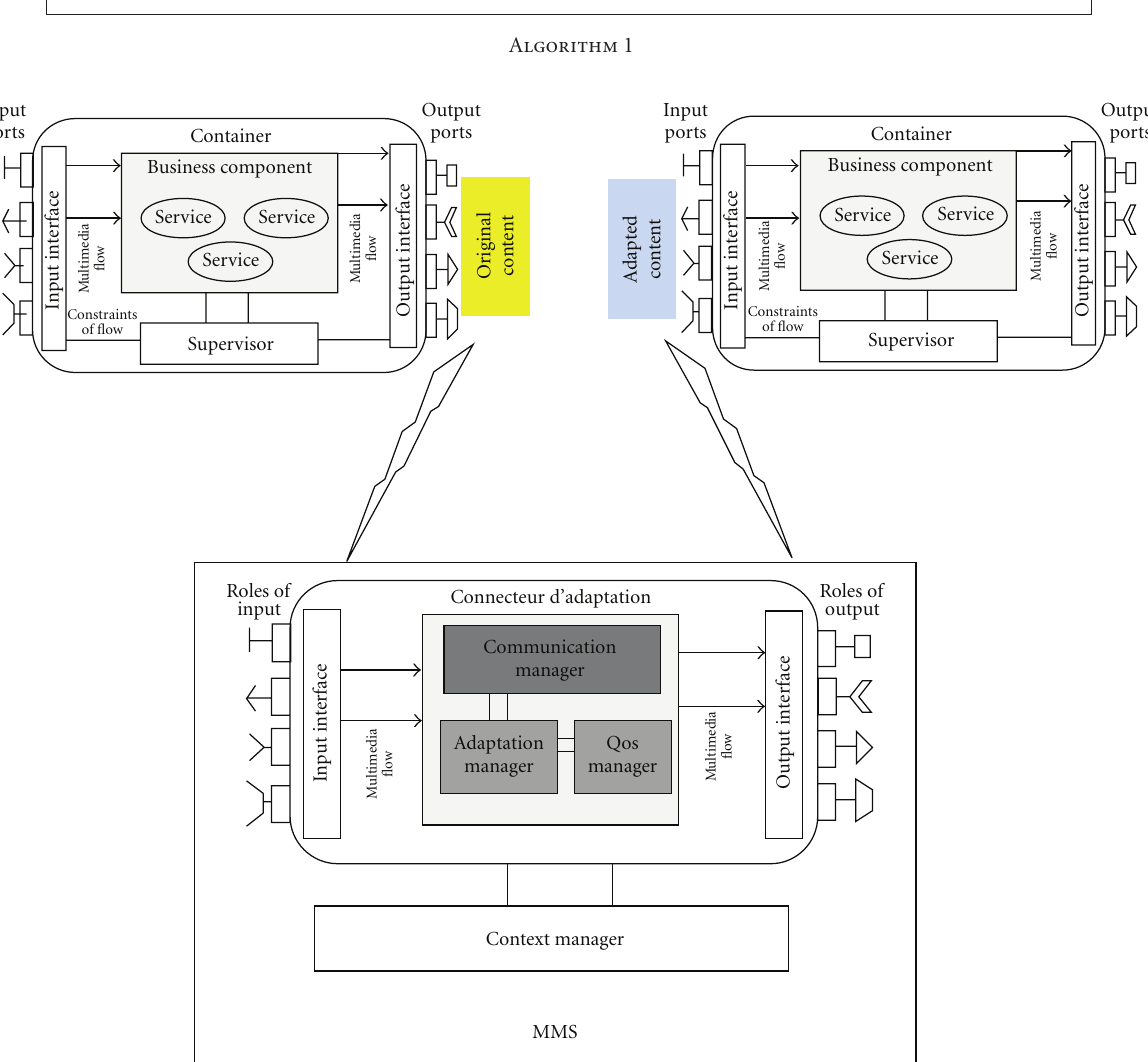
Figure 21: MMSA architecture for multimedia messaging